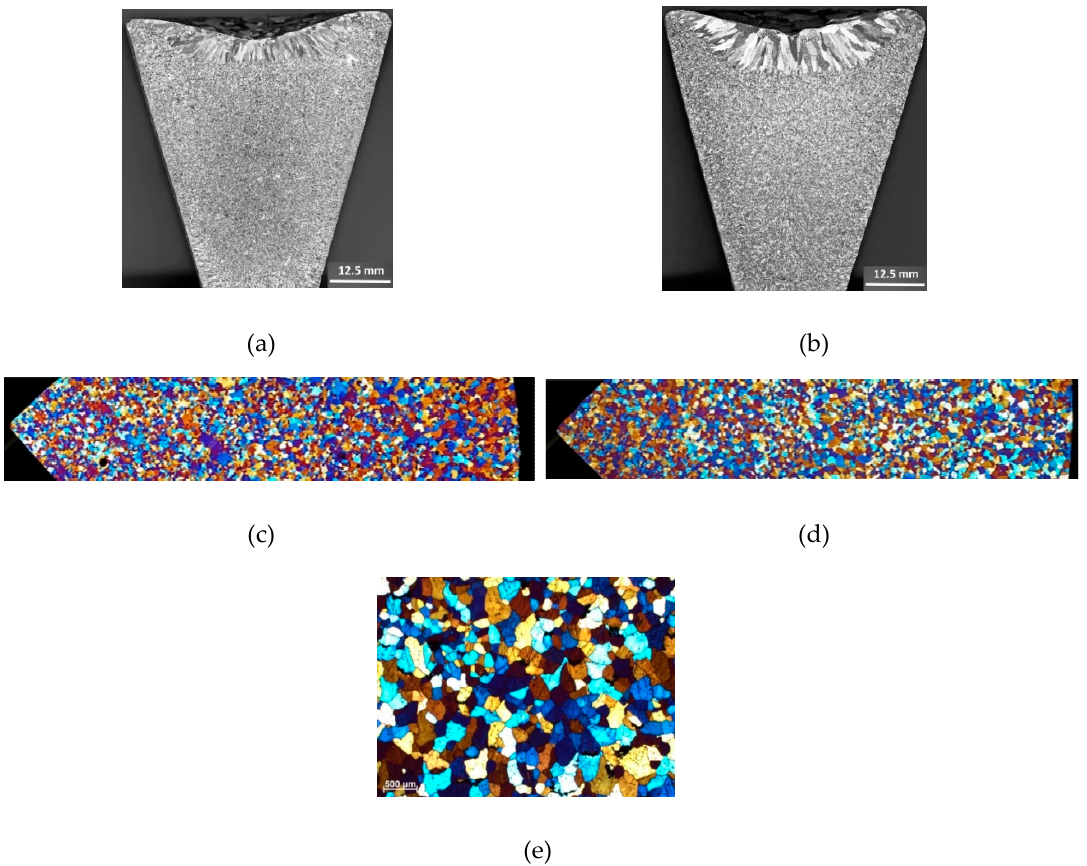
Figure 4. Effect of rod introduction with ultrasonic vibrations into the melt in the temperature range 720 to 670 °C ( a , c ) and 710 to 670 °C ( b , d , e ) on the grain structure of the alloy cast in a TP1 mould.